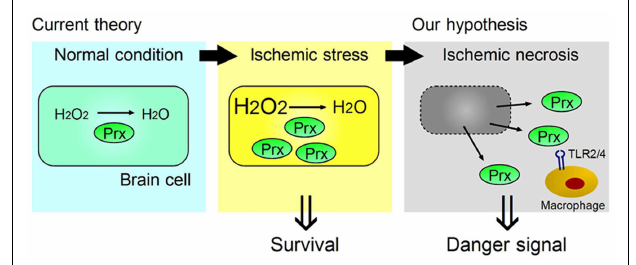
FIGURE 2 |Two opposing functions of Prx, one inside, and one outside, brain cells. Ischemic stress increases Prx expression within brain cells, which contributes to their survival by catabolizing reactive oxygen species (ROS).When ischemic phenomena finally result in necrosis, the Prx released from necrotic brain cells into the extracellular compartment then functions as a strongTLR2 andTLR4 stimulator (DAMP) for the infiltrating macrophages in ischemic brain